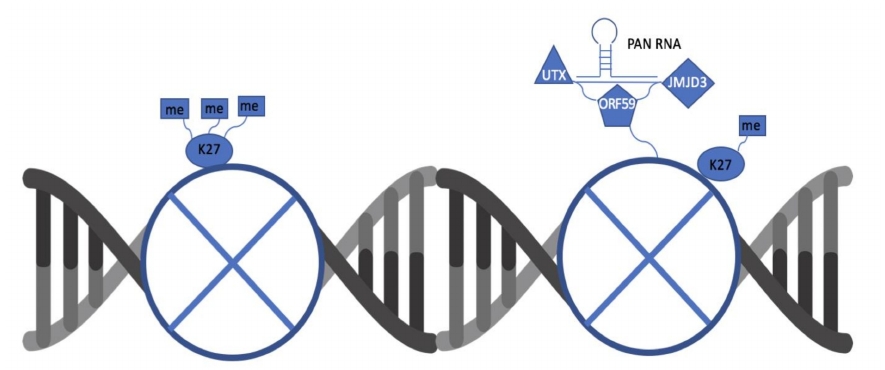
Figure 5. A schematic depicting key interactions between ORF59, PAN RNA, UTX, and JMJD3. The binding of UTX and JMJD3 to ORF59 and PAN RNA is dependent on the presence of both viral factors. This complex is responsible for removing repressive marks on the viral chromatin to promote lytic